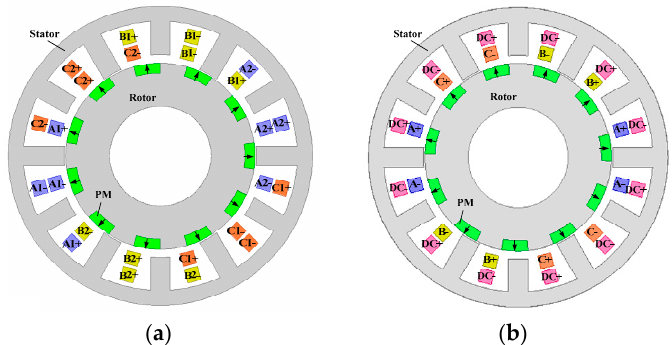
Figure 1. Machine Configurations. ( a ) The proposed DC-coil-free hybrid excited machine (DCF-HEM). ( b ) Connected with additional DC windings.